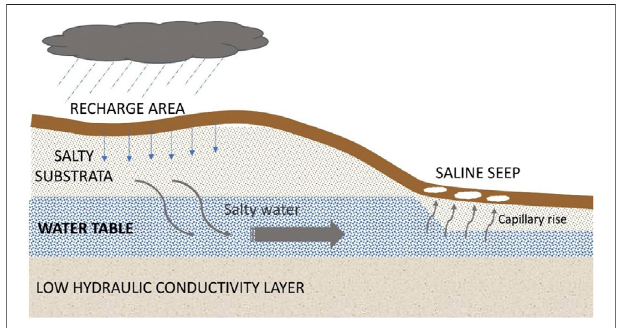
FIGURE 2 | Schematic illustration of saline seep formation.